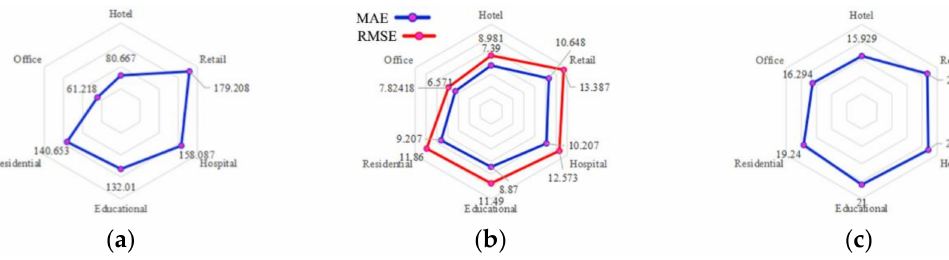
Figure 9. Statistical errors for climate model: ( a ) MSE; ( b ) MAE and RMSE; ( c ) MAPE.